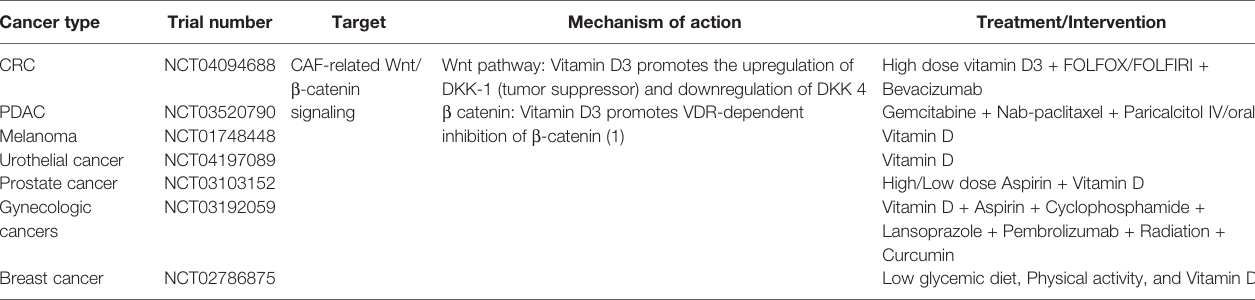
FOLFOX: leucovorin, 5- fl uorouracil, and oxaliplatin; FOLFIRI: leucovorin, 5- fl uorouracil, and irinotecan CRC, colorectal cancer; PDAC, pancreatic ductal adenocarcinoma; CAF, cancer-associated fi broblasts; VDR, vitamin D receptor; DKK 1, DICKKOPF